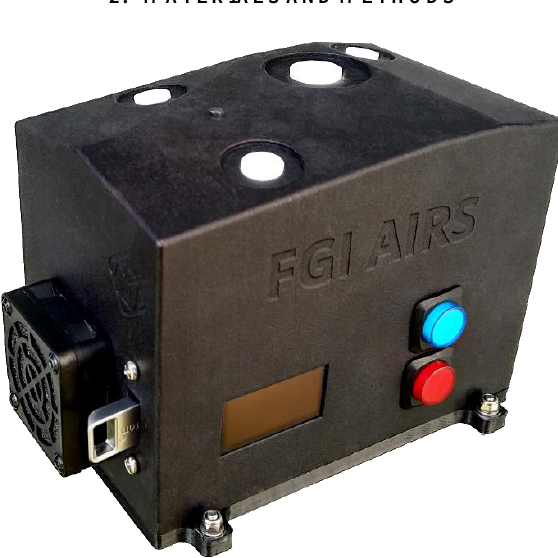
Figure 1 . The FGI AIRS sensor system which is mounted on top of a drone. The center diffuser is the cosine collector of the main irradiance spectrometer. The three tilted diffusers house photodiodes used for tilt correction.